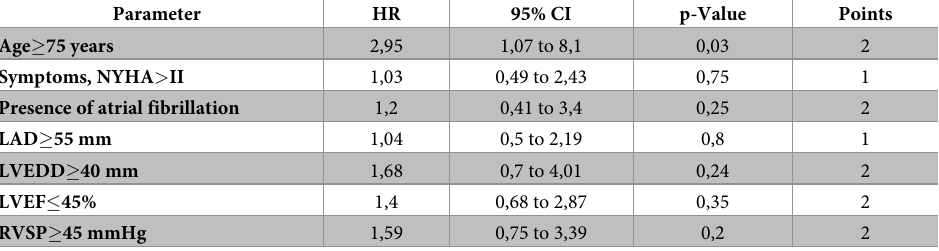
Table 4. Statistical re-weighting of parameters for the modified MIDA Score and re-arrangement of the point dis- tribution using the Cox proportional hazard analysis. Parameter HR 95% CI p-Value Points Age � 75 years 2,95 1,07 to 8,1 0,03 2 Symptoms, NYHA > II 1,03 0,49 to 2,43 0,75 1 Presence of atrial fibrillation 1,2 0,41 to 3,4 0,25 LAD � 55 mm LVEF � 45% 0,68 to 2,87 0,35 RVSP � 45 mmHg 1,59 0,75 to 3,39 0,2 2 NYHA: New York Heart Association, LAD: Left atrial diameter, LVEDD: Left ventricle enddiastolic diameter, LVEF: Left ventricle ejection fraction, RVSP: Right ventricle systolic pressure.